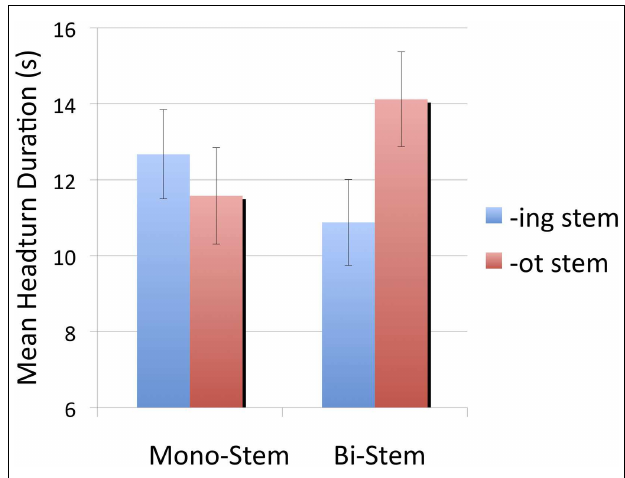
FIGURE 2 | Mean listening times for Experiment 1, organized by stem length in syllables and stem status. Error bars show standard errors.